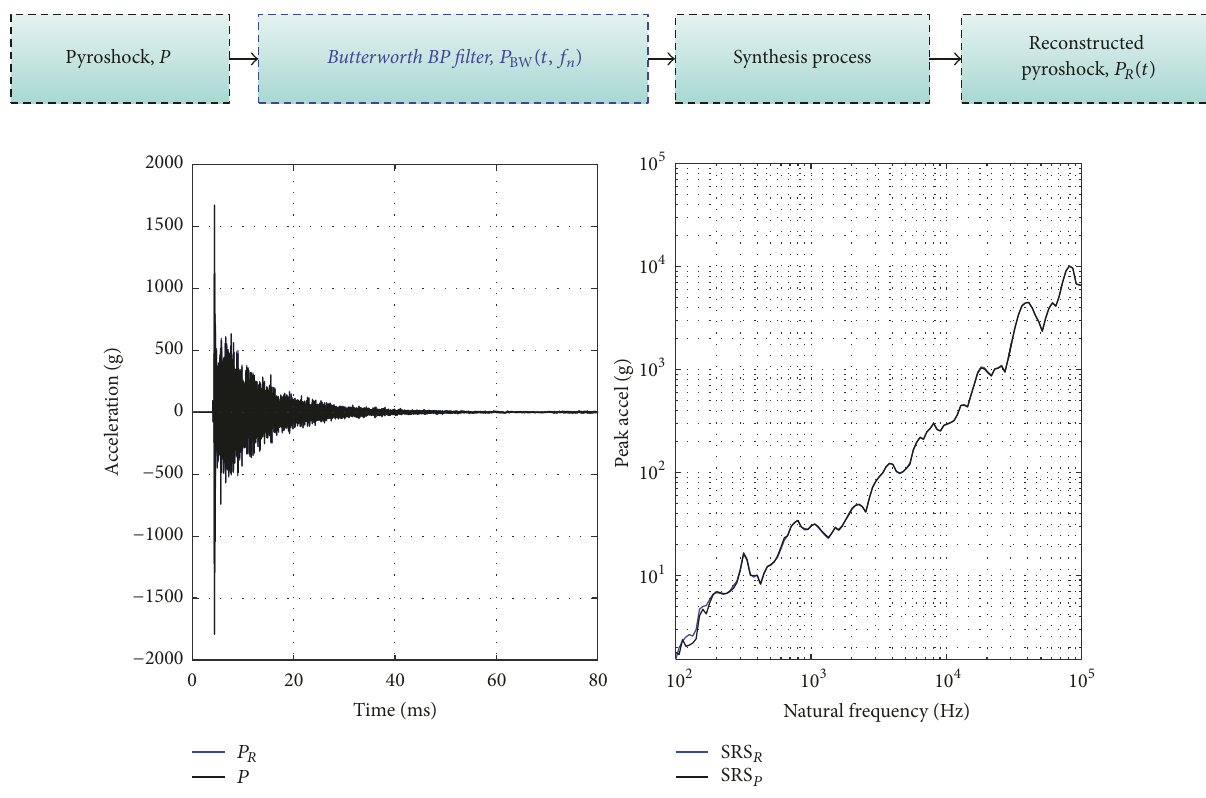
Figure 4: Signal decomposition and synthesis using Butterworth band-pass